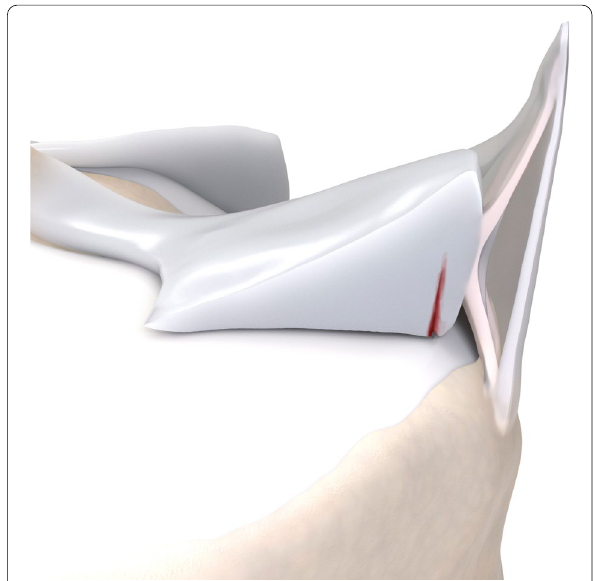
Fig. 6 Type 3A meniscal ramp lesion illustration, defined as partial inferior peripheral posterior horn meniscal tear